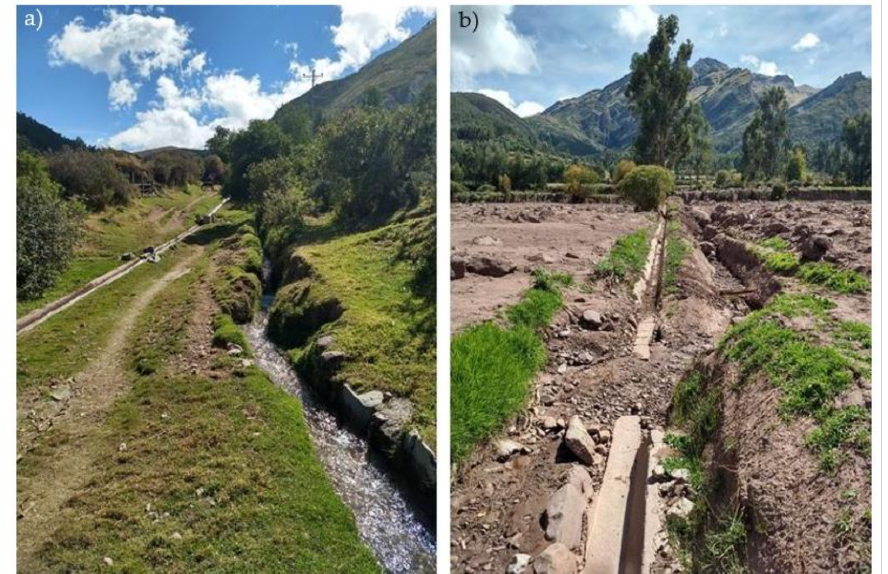
Figure 6. ( a ) A modern concrete canal with control gates adjacent to an earthen canal. ( b ) Destruction to concrete canal following March 2019 debris flow.